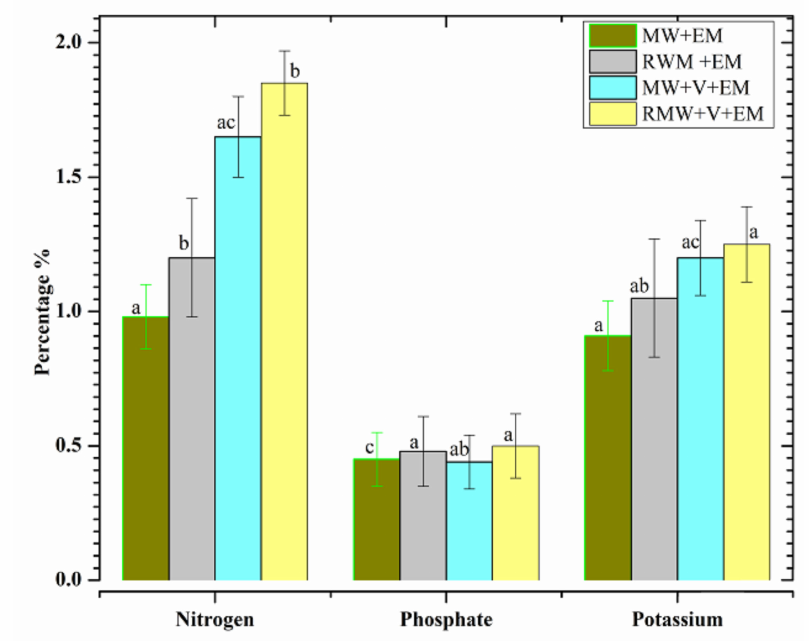
Figure 9. The total concentrations of the NPK values of [MW+EM], [RMW+EM], [MW+V+EM], and [RMW+V+EM]. Error bars represent standard errors for six samples. Columns followed by the same letter do not differ significantly (ANOVA; Tukey’s test, p <